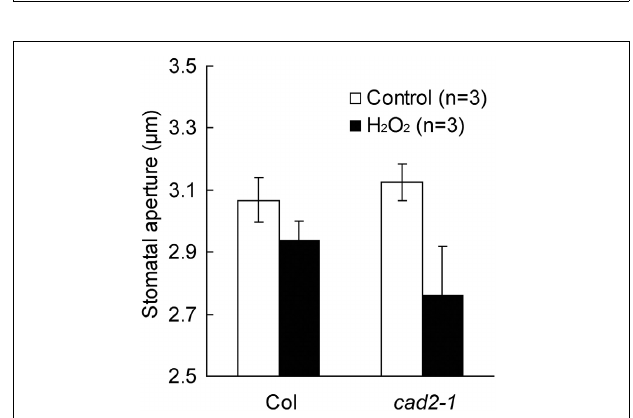
wild-type GCPs without ABA (upper trace) or with 10 μ M ABA (Lower trace). (B) Representative current traces of cad2-1 GCPs without ABA (upper trace) or with 10 μ M ABA (Lower trace). (C) Average current-voltage curves of wild-type GCPs and cad2-1 GCPs as recorded in (A) and (B) . The voltage protocol was stepped-up from + 35 to − 145mV in 30-mV decrements (holding potential: + 30mV). GCPs were treated with 10 μ M ABA for 30min before recordings. The bars represent the mean ± SE values of at least five independent replicates.